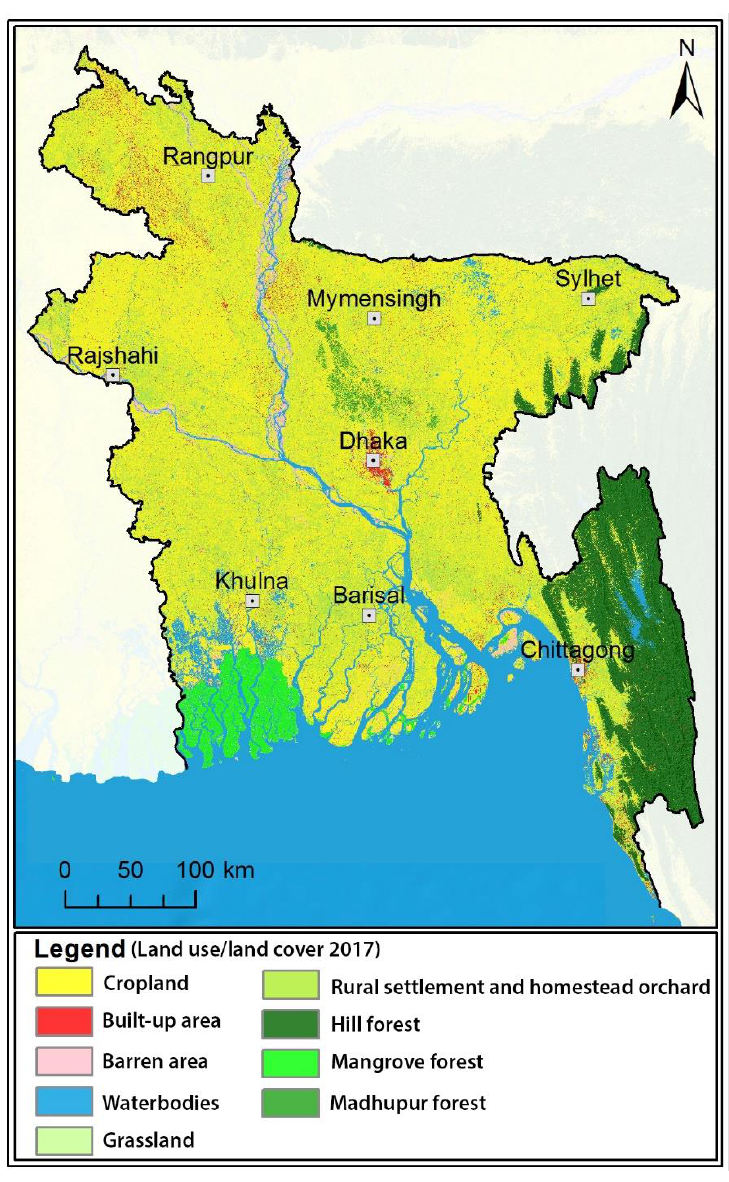
Figure 6. 2017 land cover map of Bangladesh developed using Landsat 8 and Google Earth Engine cloud computing.